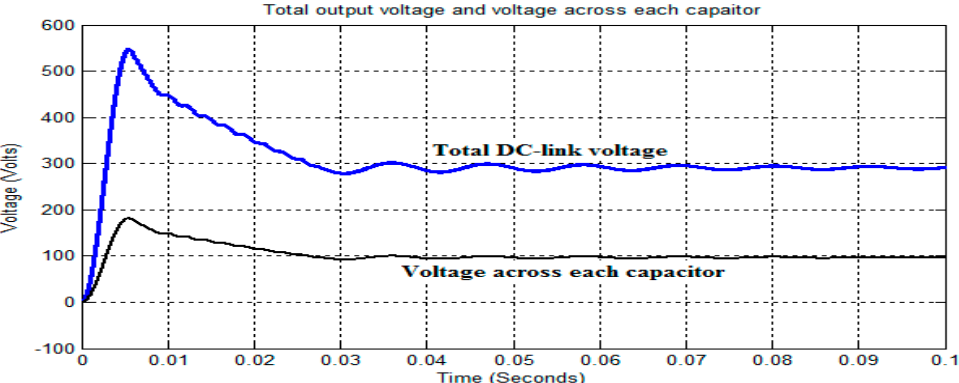
Figure 11. Output of TLBC in open-loop for D = 0.4.